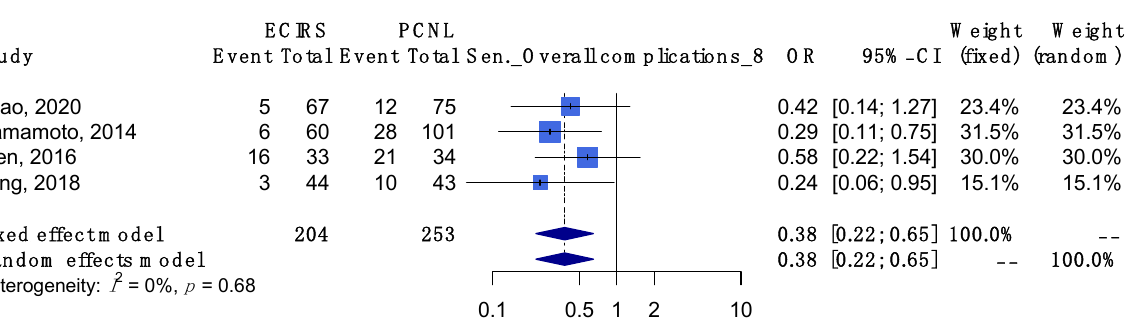
Figure A29. Sensitivity analysis of outcome regarding final stone free rate. ([17,19,22])